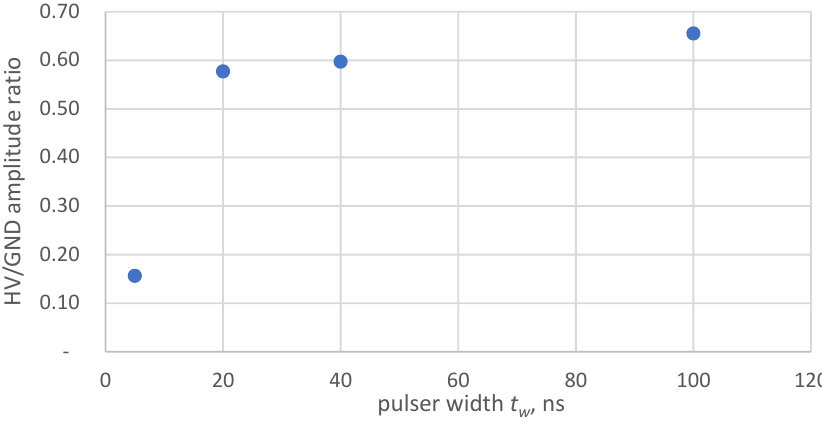
Figure 15. Impact of pulser width t w on the ratio of measured signal amplitudes generated by charge at GND and HV electrodes, PVDF sensor d s = 9 µm, d = 1 mm LDPE sample.